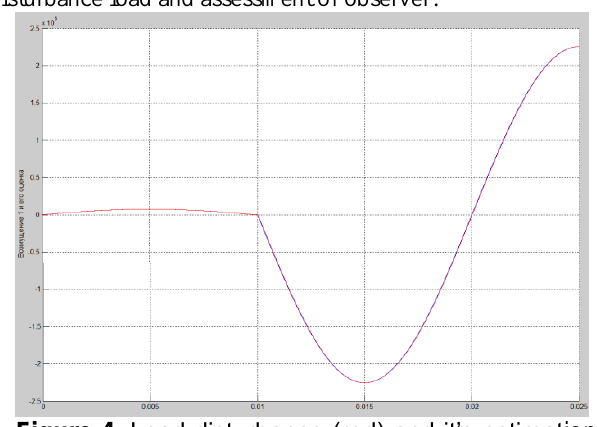
Figure 4. Load disturbance (red) and it’s estimat ion (blue) by